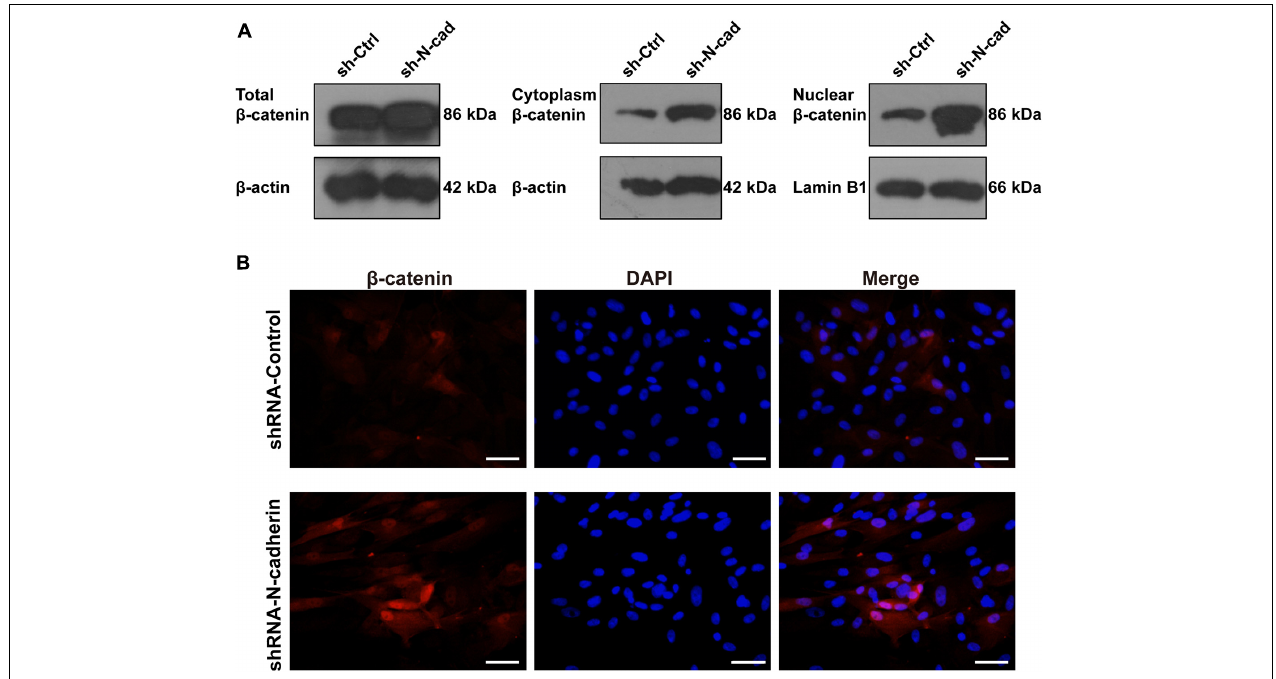
FIGURE 4 | N-cadherin downregulation enhanced β -catenin activity in dental pulp stem cells (DPSCs). DPSCs transfected with a control or N-cadherin-specific shRNA lentivirus were subjected to odontogenic induction for 14 days. The expression level of nuclear, cytoplasmic, and total β -catenin was detected by western blotting (A) . The nuclear translocation of β -catenin was detected by immunofluorescent staining. Nuclei were counterstained with DAPI (B) . Scale bars = 50 µ